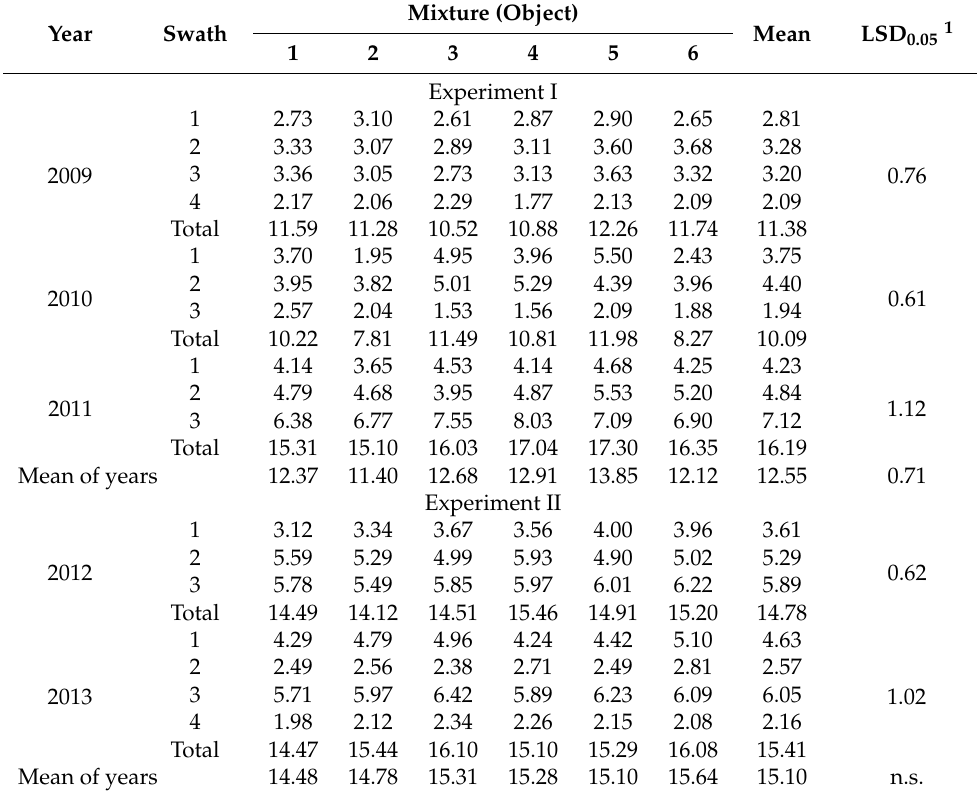
Table 7. Dry matter (DM) yield in t · ha − 1 from experiments I and